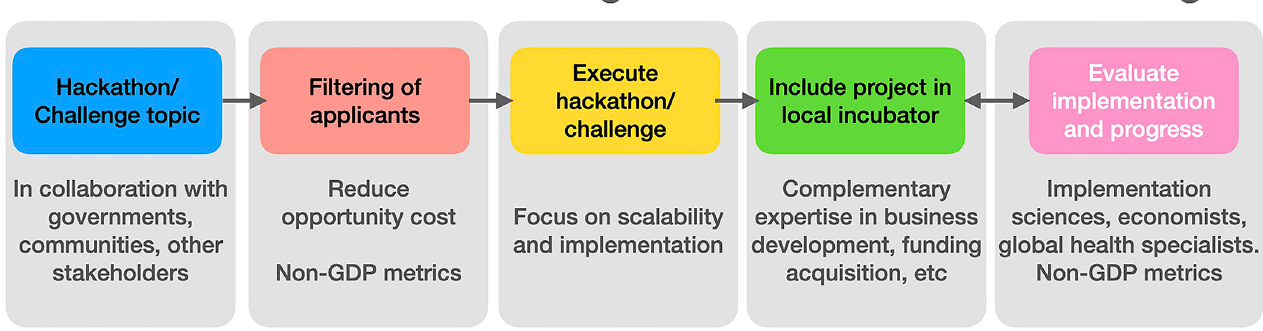
Fig 2. A venture building approach around challenges in global health. Any Challenge needs to be nested in a venture building approach guiding the development of digital health technologies. This includes filtering of participants, close integration of implementation scientists to ensure sustainability and scalability, and an incubator following the Challenge event for long-term development of the ideas resulting from the